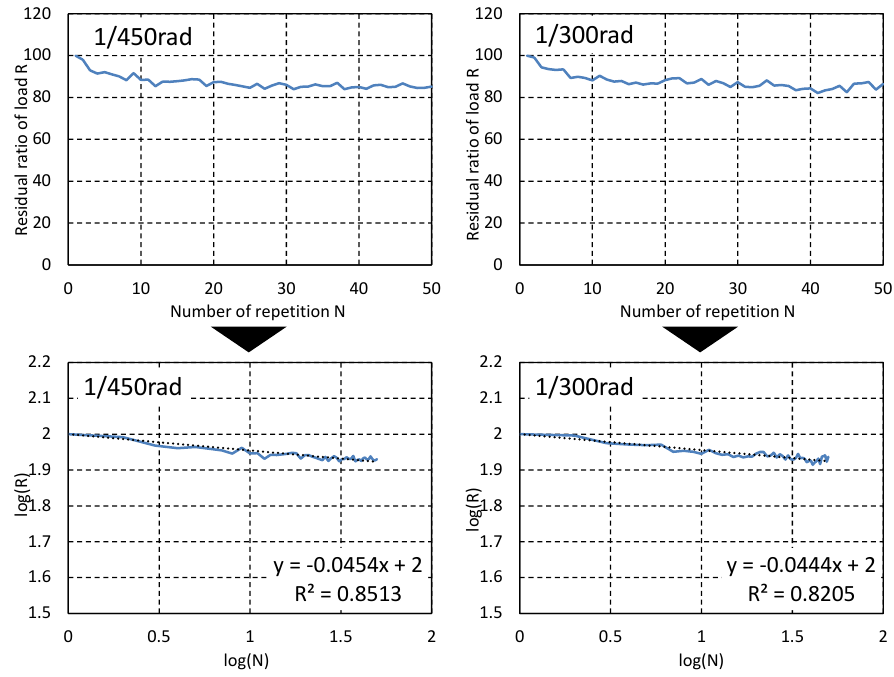
Figure 4. Relationship between logarithmic load residual ratio and number of repetitions.